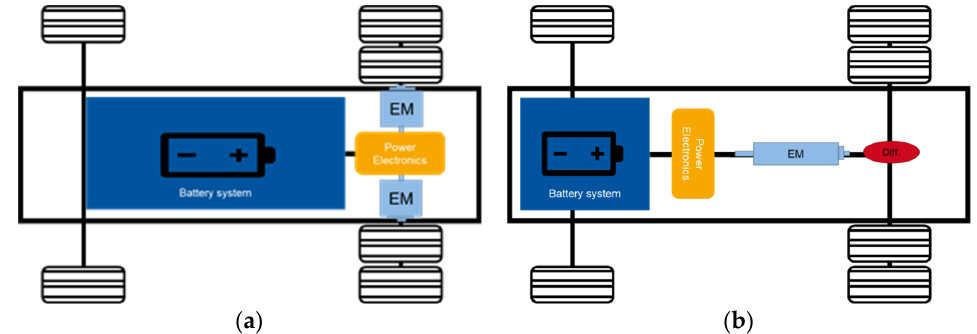
Figure 8. Illustration of suitable geometry for ( a ) an in ‐ wheel e ‐ machine and ( b ) central arrange ‐ ment.